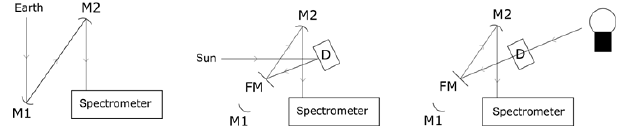
Figure 5. Schematic optical path. The left panel shows the config- uration for Earth radiance measurements. M1 and M2 correspond to the primary and secondary mirrors of the telescope. The mid- dle panel shows the configuration for Sun irradiance measurements, with the folding mirror FM placed between M1 and M2. Sunlight enters the instrument via diffuser D in reflection mode and the FM and M2. The right panel shows the configuration for internal cali- bration measurements. The light from the white light source passes diffuser D in transmission mode and enters the instrument via FM and